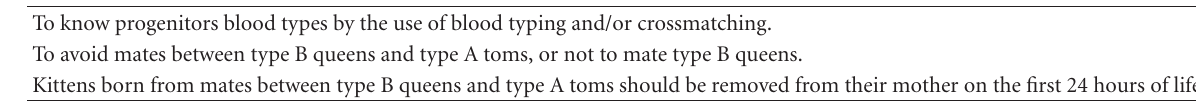
Table 6: Fundamental steps for feline neonatal isoerythrolysis prevention. To know progenitors blood types by the use of blood typing and/or crossmatching. To avoid mates between type B queens and type A toms, or not to mate type B